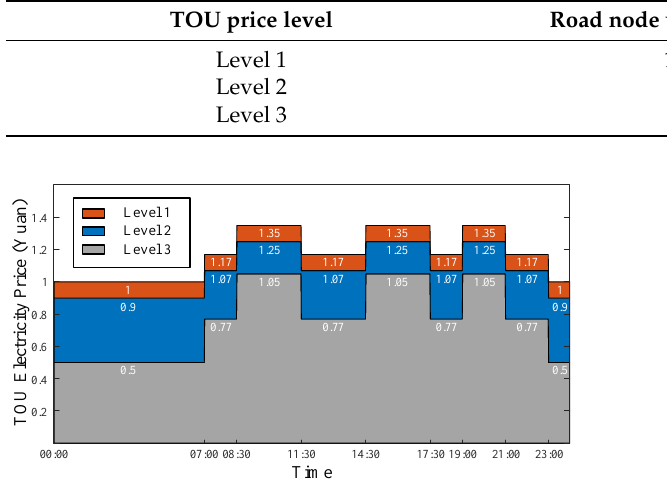
Table A5. Each level of electricity price corresponds to the road node where the charging station is located. TOU price level Road node where the EVCS is located